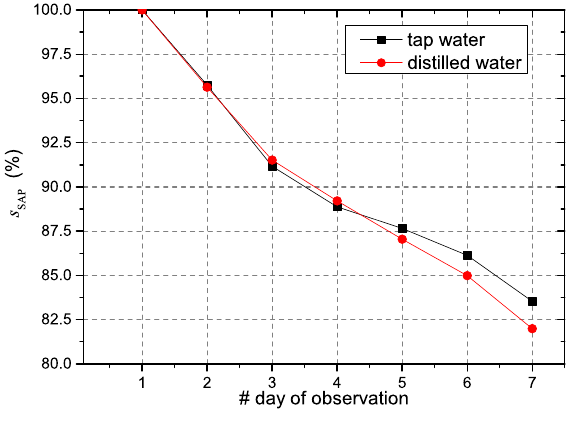
Figure 3. Water desaturation of the two samples of SAP mixed with distilled water and with tap water, in the seven-day observation period.